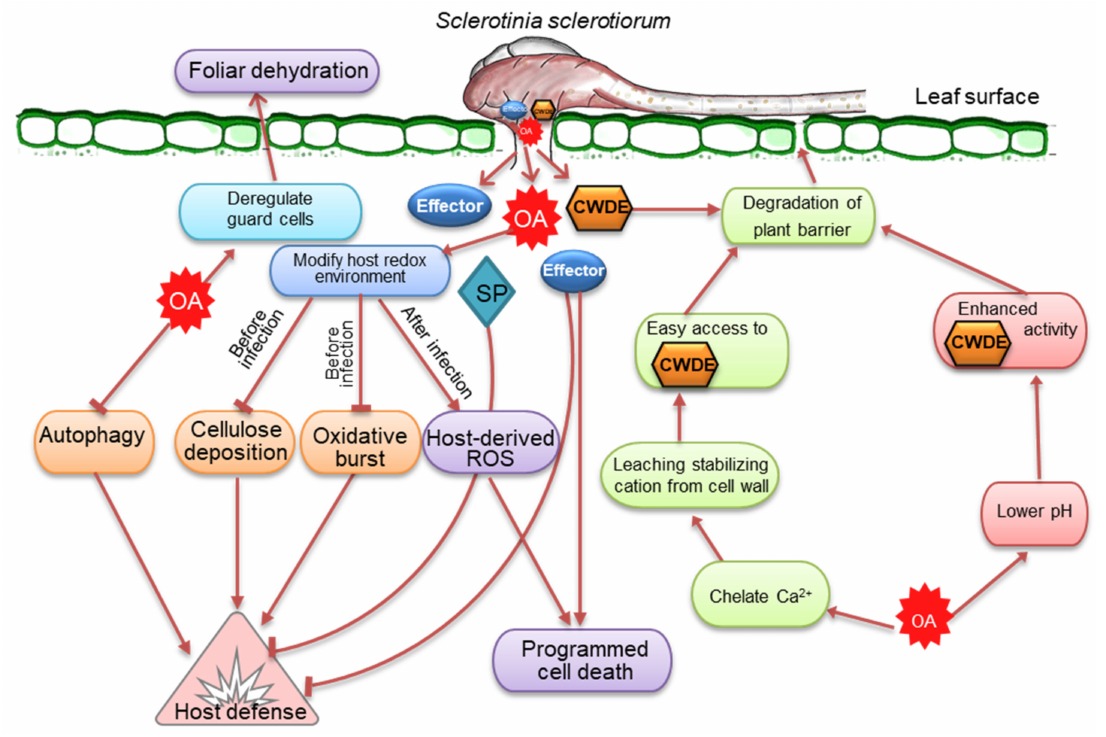
Figure 4. The frontline weapons or virulence factors of Sclerotinia sclerotiorum important for developing and regulating the infection process in plants. S. sclerotiorum releases oxalic acid (OA), which